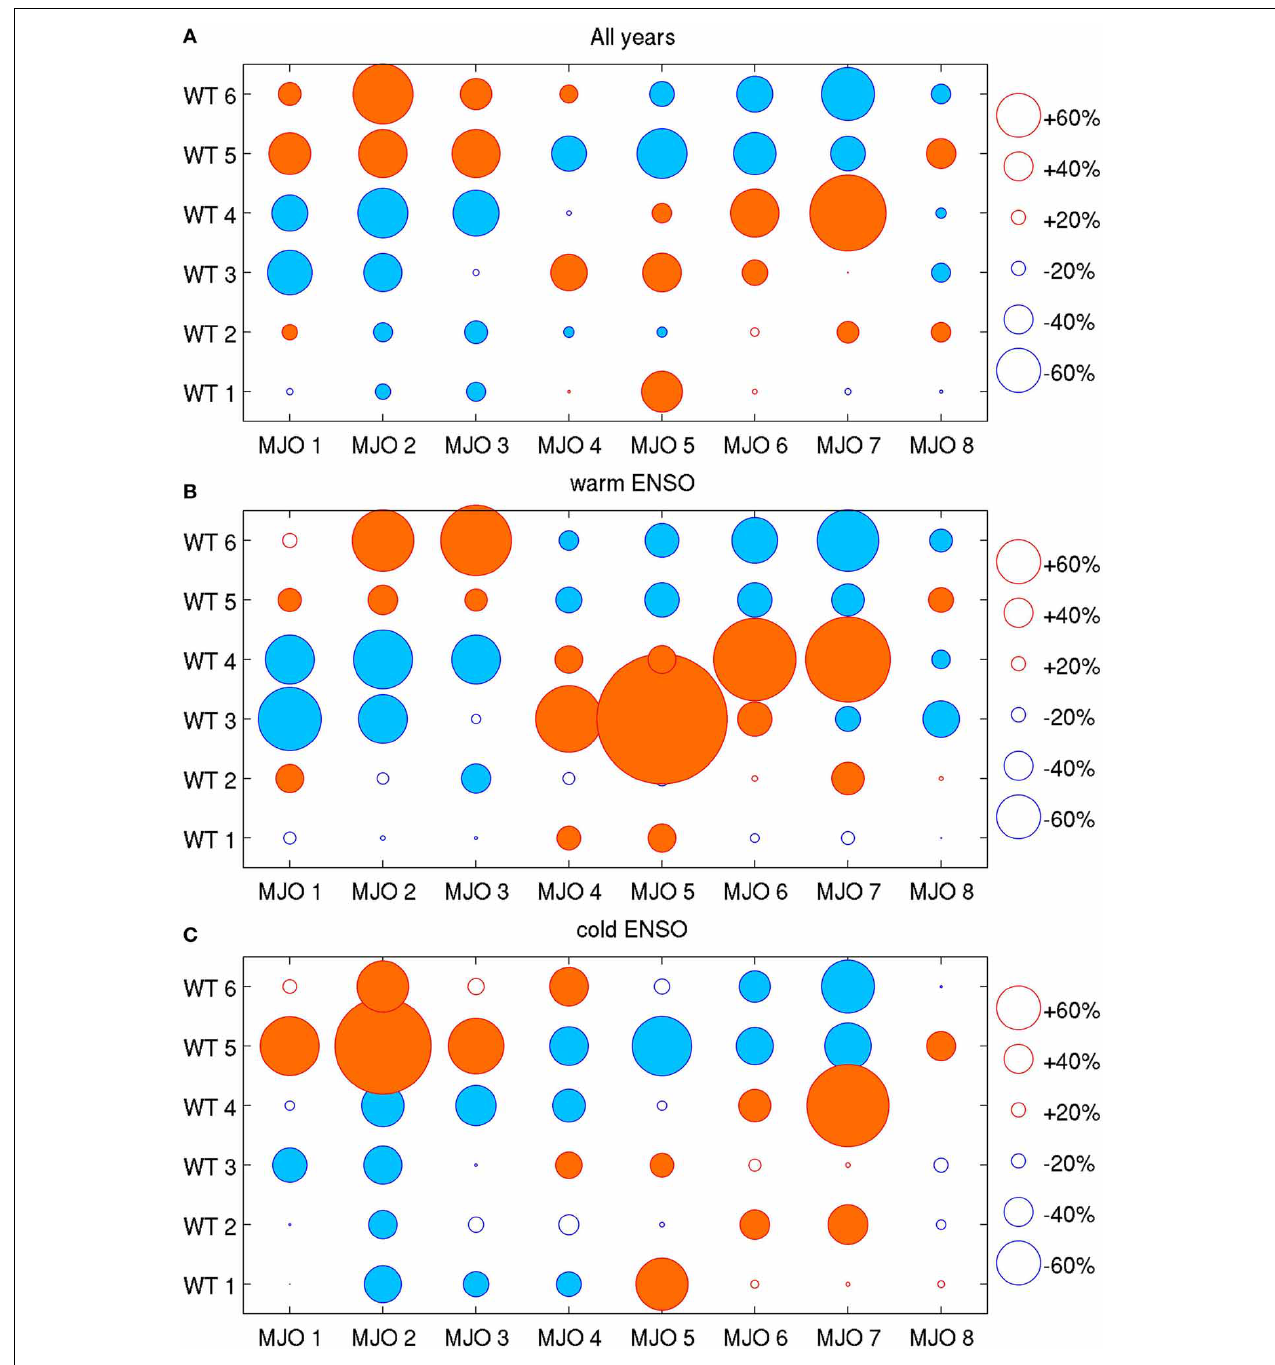
FIGURE 7 | Phase locking of the WTs to the 8 phases of the MJO (Wheeler and Hendon, 2004; Kondrashov et al., 2013) expressed as anomalous conditional probability of WT occurrence during MJO phases. The filled orange and blue dots indicate significant positive and